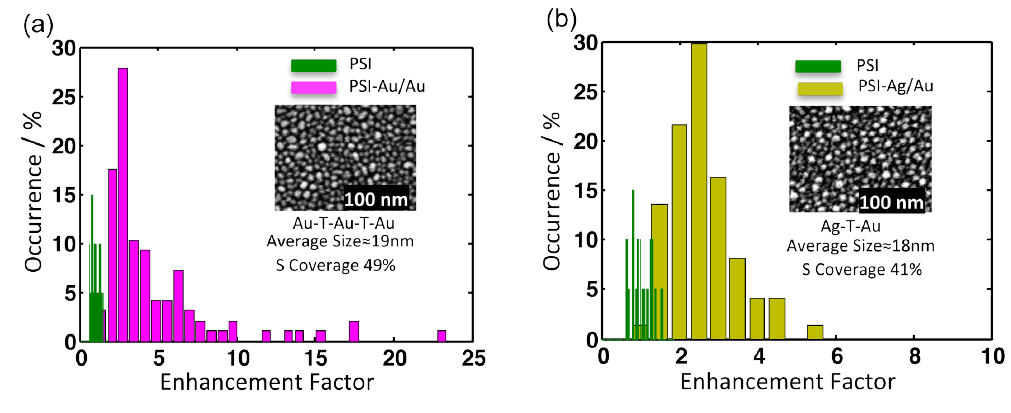
Figure 5. Comparison of the integrated fluorescence intensities of ( a ) PSI-Au/Au (magenta) and ( b ) PSI-Ag/Au (yellow) with PSI-glass in green. The insets are the SEM images